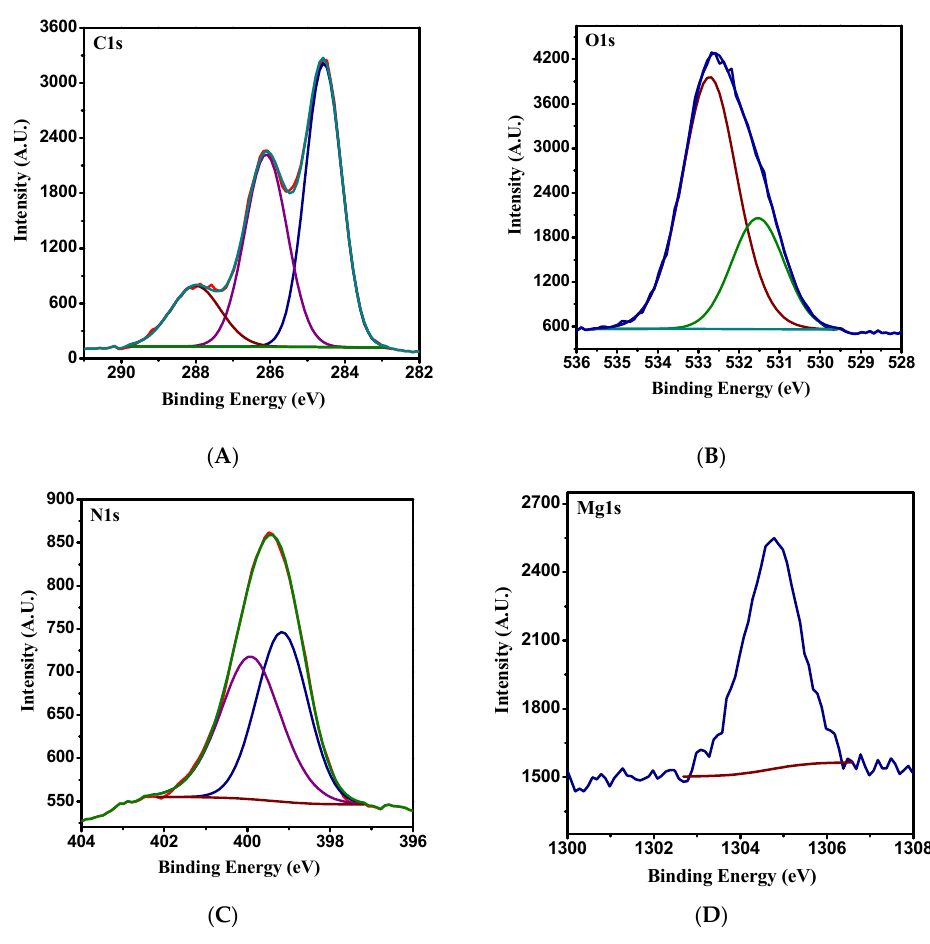
Figure 2. XPS binding energies 10 wt.% magnesia /chitosan hybrid film, spectra of C1s peak ( A ), O1s peak ( B ), N1s peak ( C ), Mg1s peak ( D ).